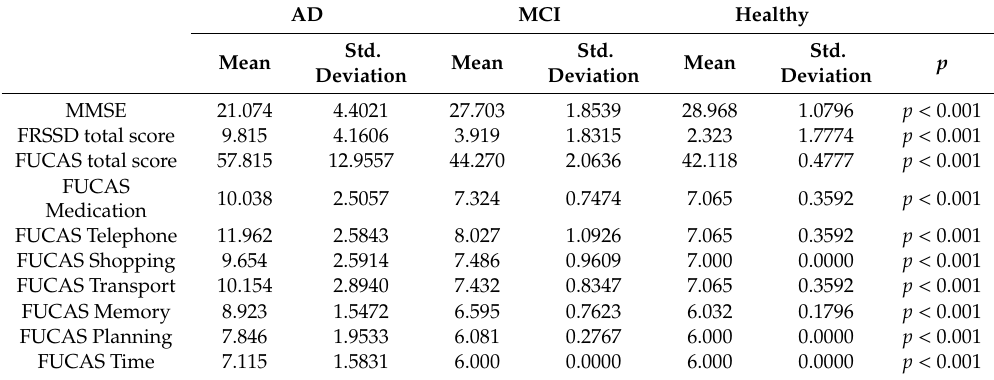
Table 3. Comparison between the patients with MCI, the patients with Alzheimer’s disease (AD) and the healthy